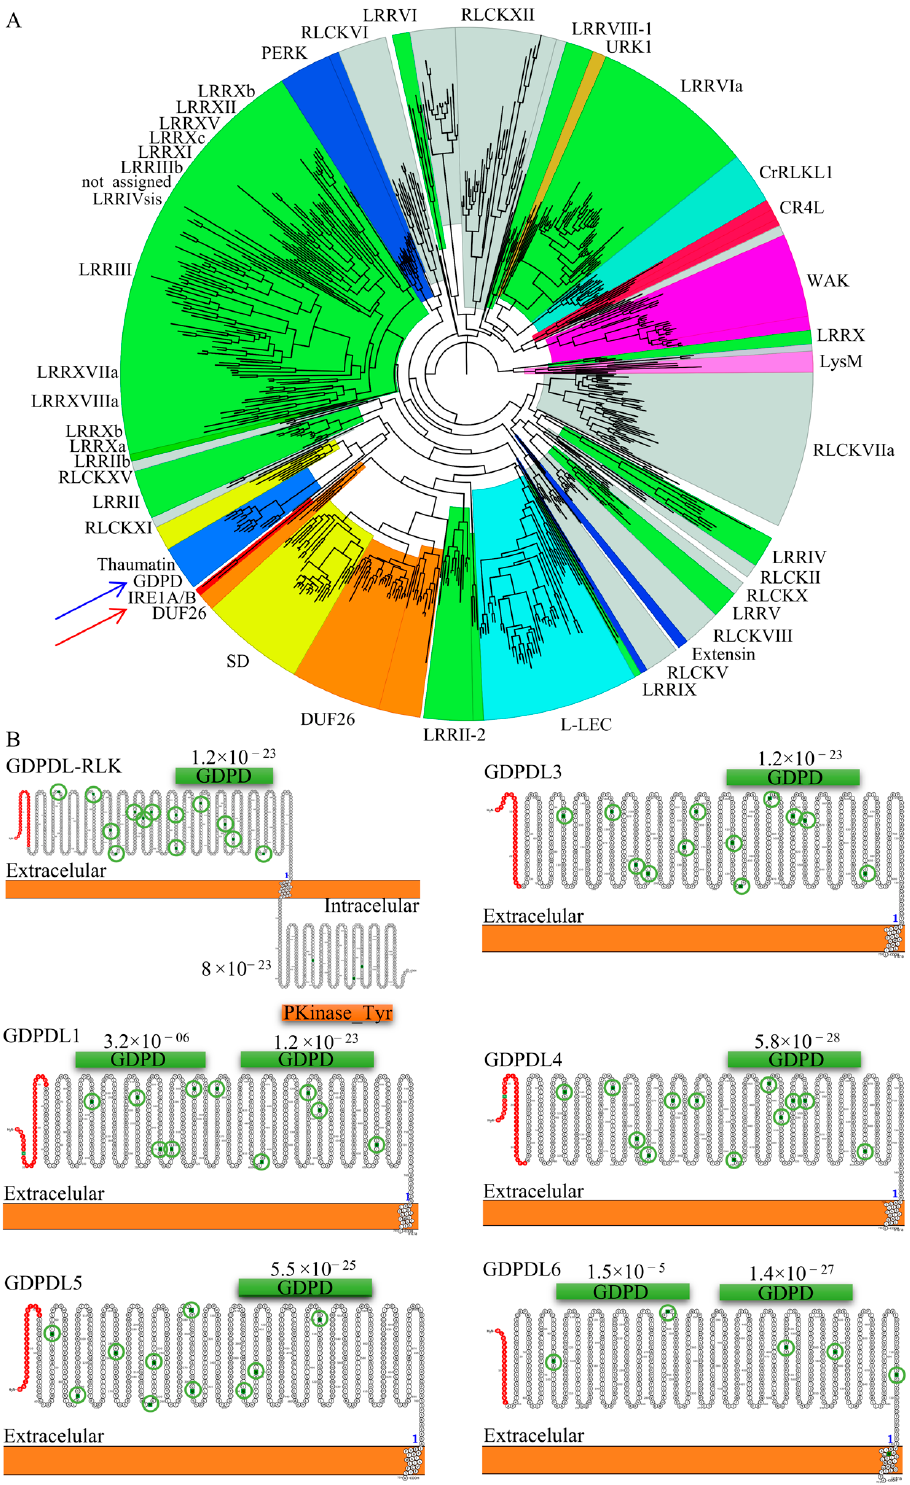
Figure 2. Analysis in silico of the GDPDL-RLPs. ( A ) Phylogenetic tree of the kinase catalytic domain of RLKs, IRE1A and IRE1B. ( B ) The topology of GDPDL-RLPs.